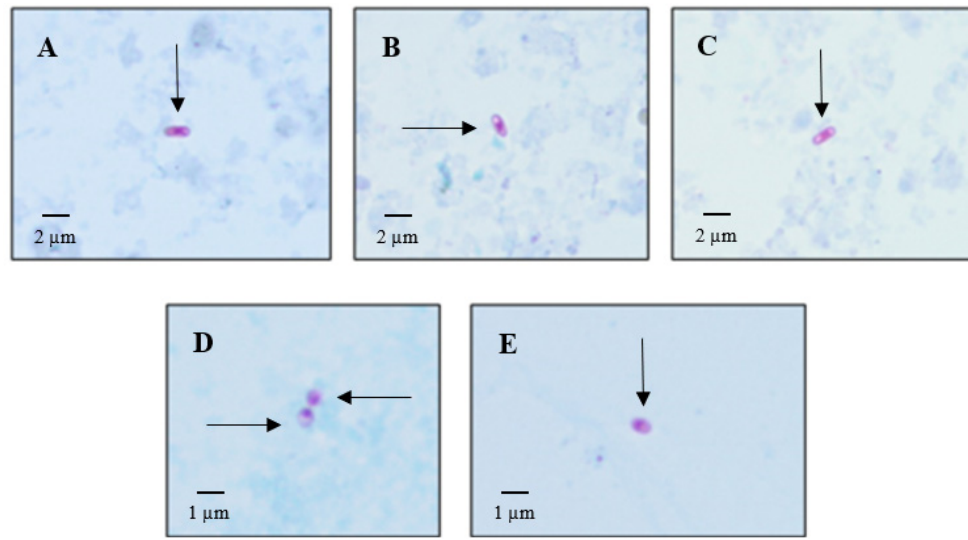
Figure 4. Microsporidia spores stained with Modified Trichrome in urine sediment. ( A – C ): spores compatible with the genus Encephalitozoon (size: 2–3 µ m, magnification: 1000 × ). ( D , E ): spores consistent with the species Enterocytozoon bieneusi (length: 1–1.2 µ m, magnification: 1000 ×